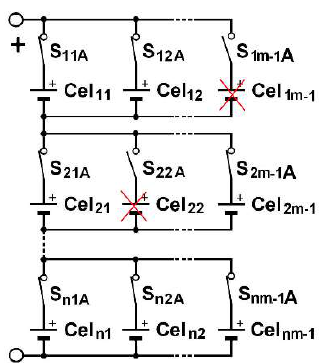
Figure 6. Fault tolerant SP architecture.